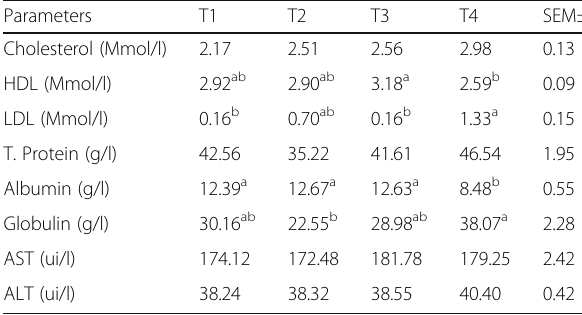
Table 7 Serum biochemical indices of broiler fed fungi treated cocoa pod husk